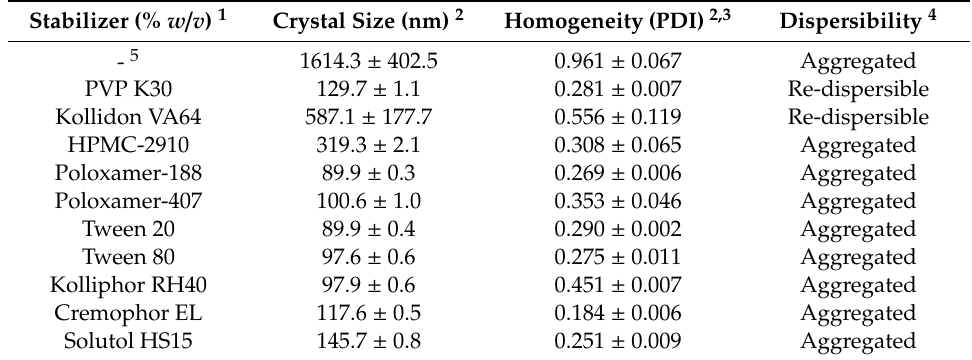
Table 1. E ff ect of di ff erent types of stabilizers on the crystal size, homogeneity, and dispersibility of MTK nanocrystals in the aqueous